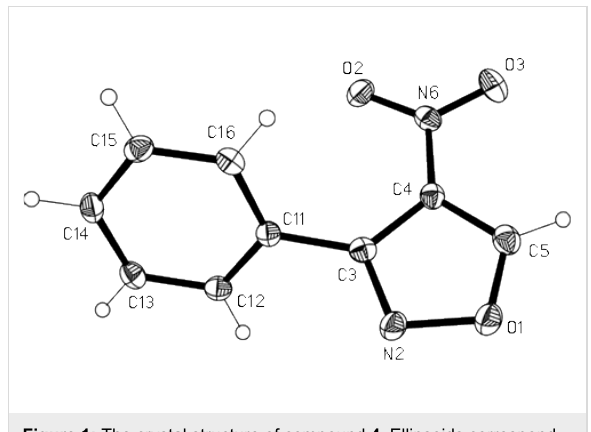
A suggested mechanism for the formation of 4 is outlined in Scheme 2.